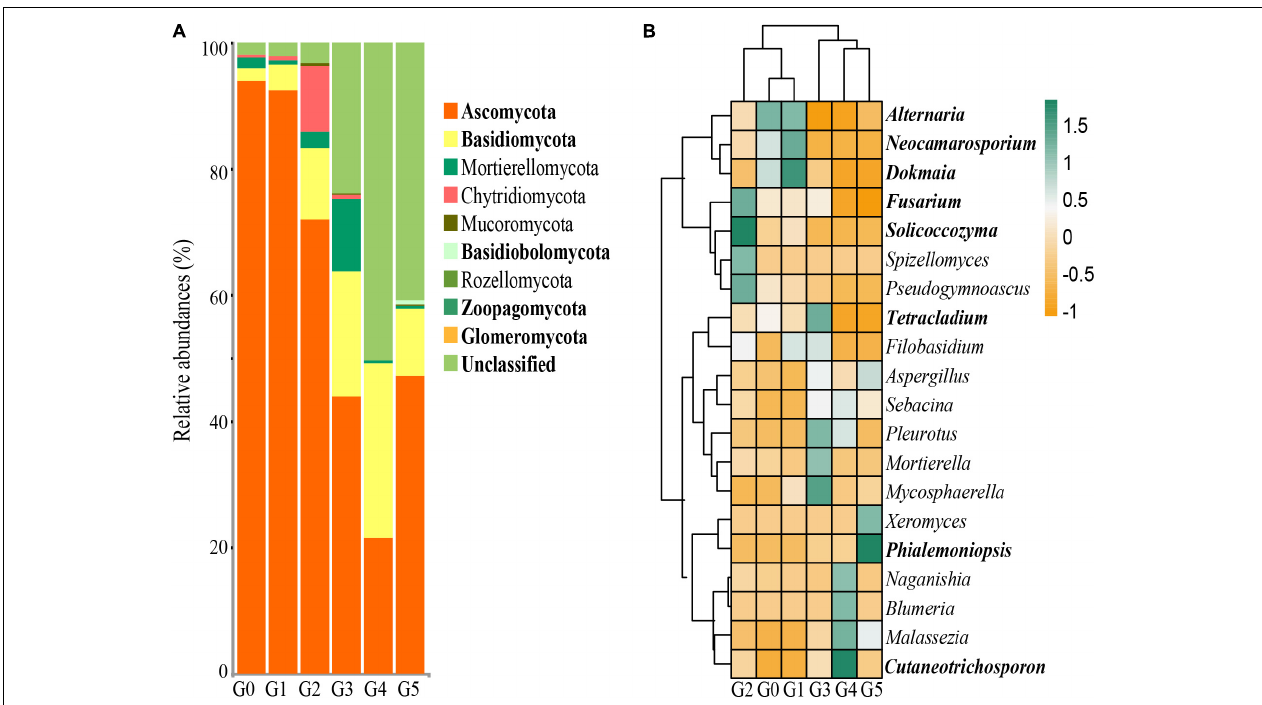
FIGURE 4 | (A) Relative abundances of soil fungi at the phylum level. (B) Heatmap based on the relative abundance of the top 20 fungal genera. Bolded font indicates a significant difference at the p < 0.05 level by